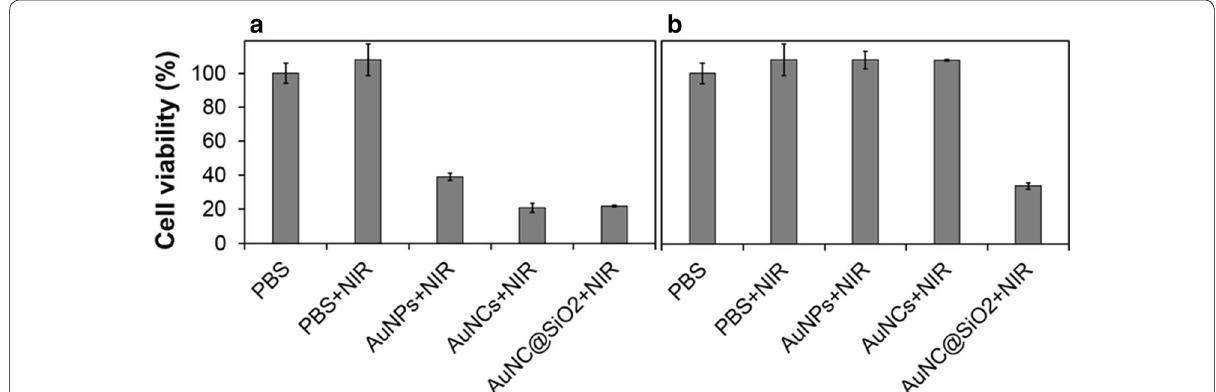
Fig. 4 Photothermal efficiency of each sample in four different conditions. Histogram ( a ) shows cell viability when using the samples immediately after fabrication. Histogram ( b ) cells cultured in PBS for 7 days. Cells were subjected to 808 nm wavelength NIR irradiation after being cultured in PBS, AuNP, AuNC, and AuNC@SiO 2 . All measurements were done in